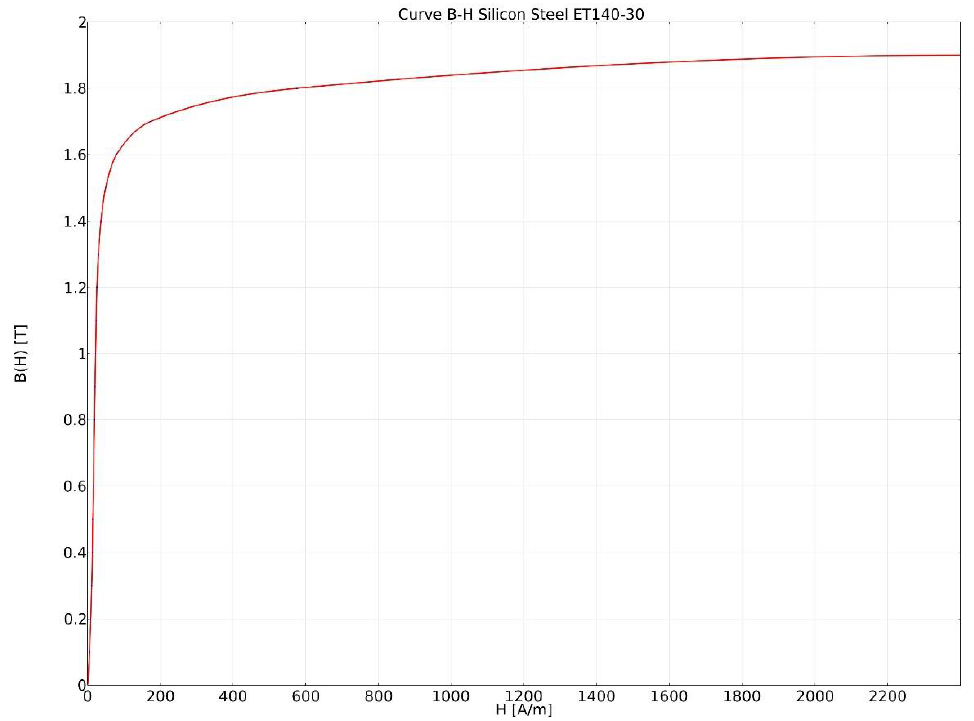
Figure 5. The magnetisation curve of silicon steel Et140-30.